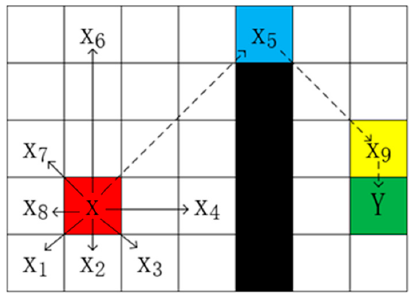
Figure 3. Key point extraction diagram. (The red square is the starting point, the blue square and the yellow square are the characteristic points in the path, and the green square is the ending point)